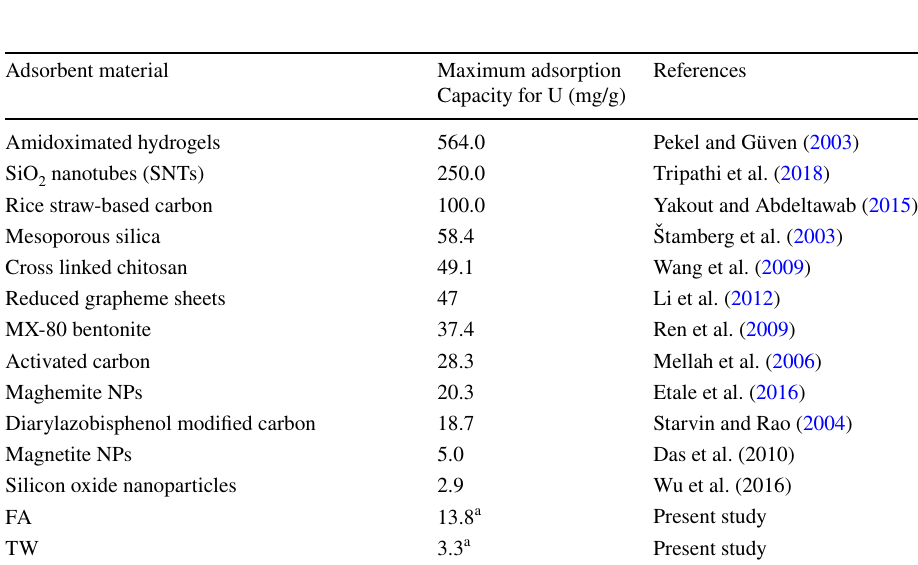
Table 4 Freundlich and D–R isotherm constants for the adsorption of U on FA and TW